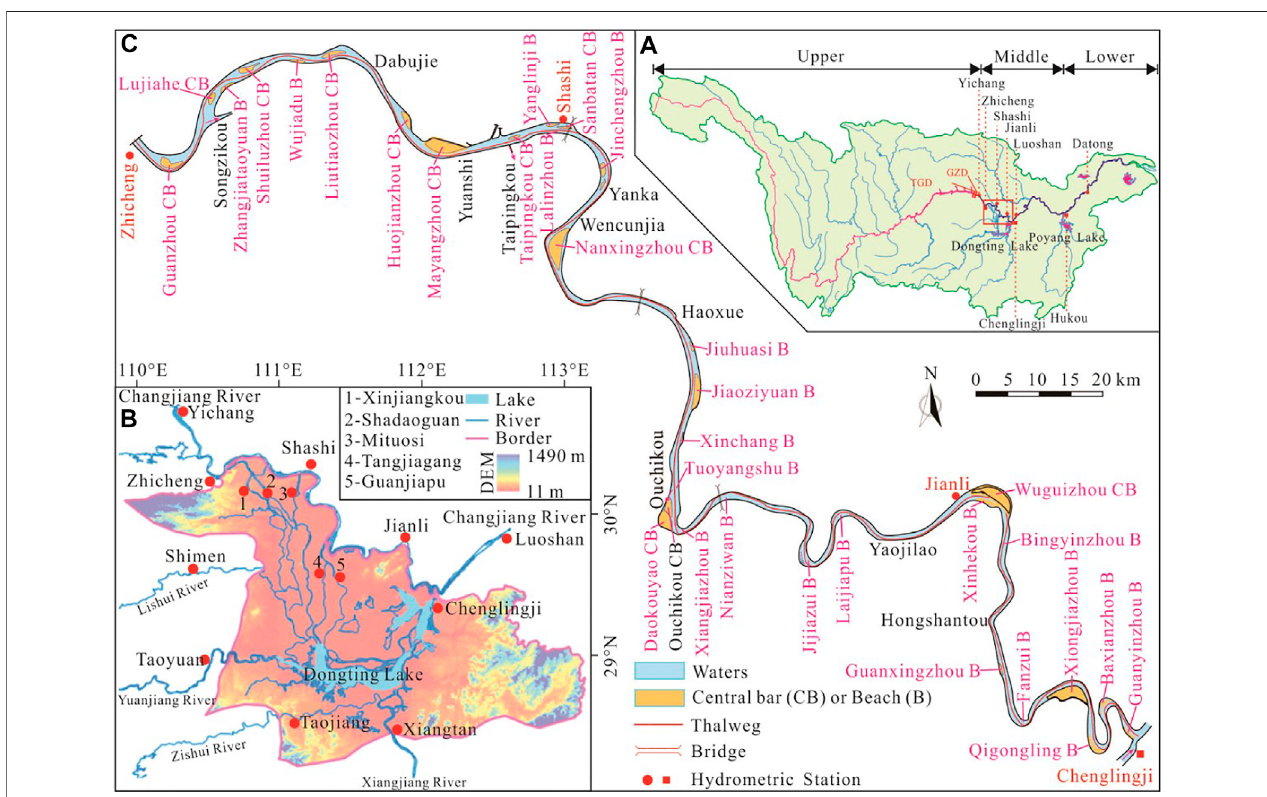
FIGURE 1 | Overview of the middle reaches of the Changjiang River and Dongting Lake; (A) Changjiang River Basin; (B) Relationship between Dongting Lake and Jingjiang reach; (C) Jingjiang reach.